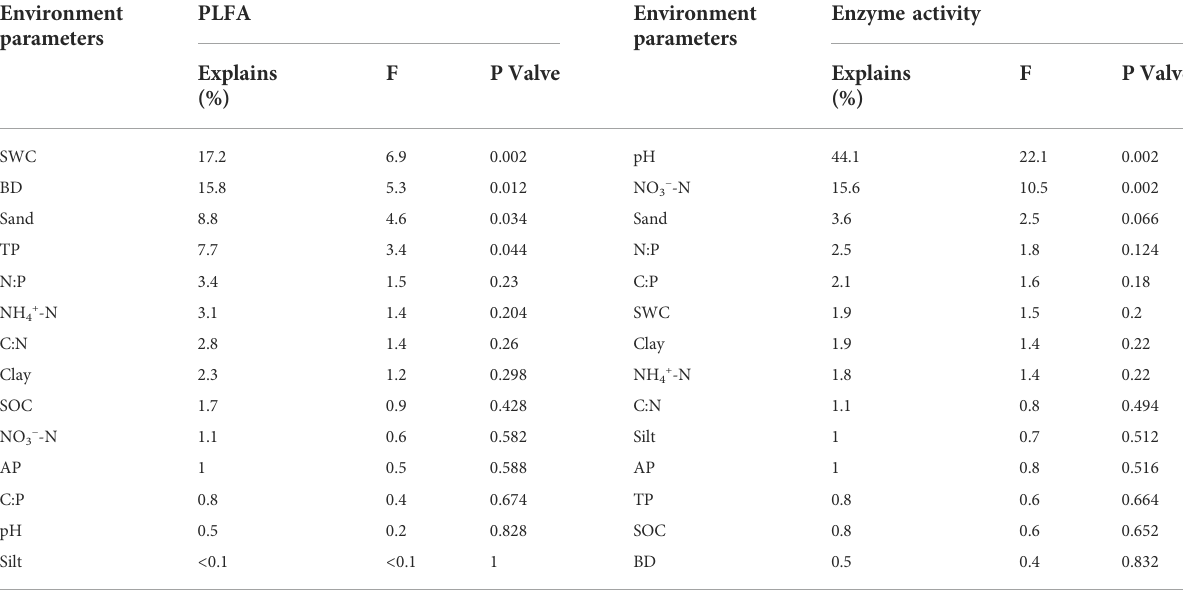
TABLE 2 Results of redundancy analysis of soil microbial and enzymatic variation using environmental variables, determined by forward selection procedure with unrestricted permutation tests. Environment parameters